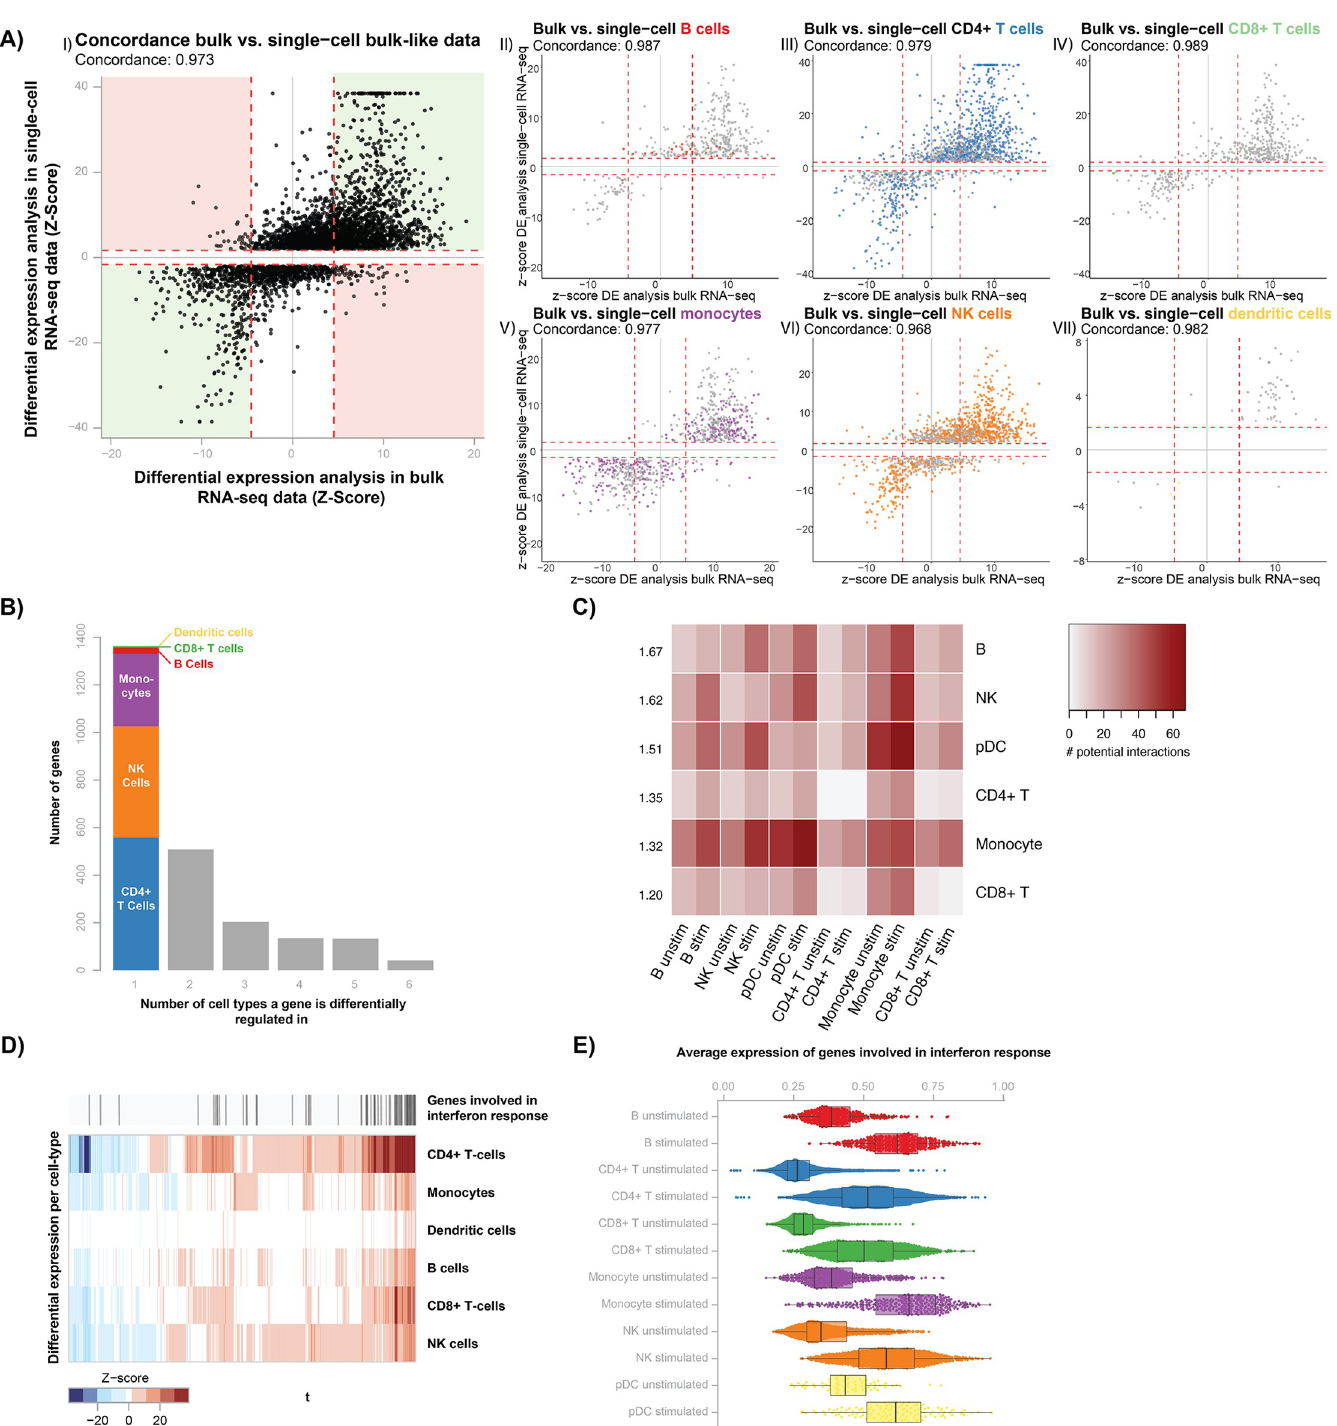
Fig 1. Single-cell RNA-seq differential expression analysis reveals the cell type-specific response to Candida stimulation. (A) Comparison of differentially expressed (DE) genes upon Candida stimulation identified in 6 individuals for whom single-cell RNA-seq (scRNA-seq) data is generated (y-axis) as compared to the effect in 70 bulk RNA-seq samples (x-axis). Each dot represents a DE gene and the dotted red lines indicate the significance thresholds. In panel I (DE genes in bulk-like scRNA-seq sample, which contains all cells from an individual), concordant DE genes are shown in the green area and discordant genes in the red area. In panels II-VII (DE genes in specific cell type), color indicates whether a DE gene is cell type-specific. (B) Bar plot showing the sharedness of DE genes across cell types. The first bar, with cell type-specific DE genes, is colored based on the cell type in which the DE gene is found. (C) Heatmap of the total number of ligand-receptor interactions between cells of